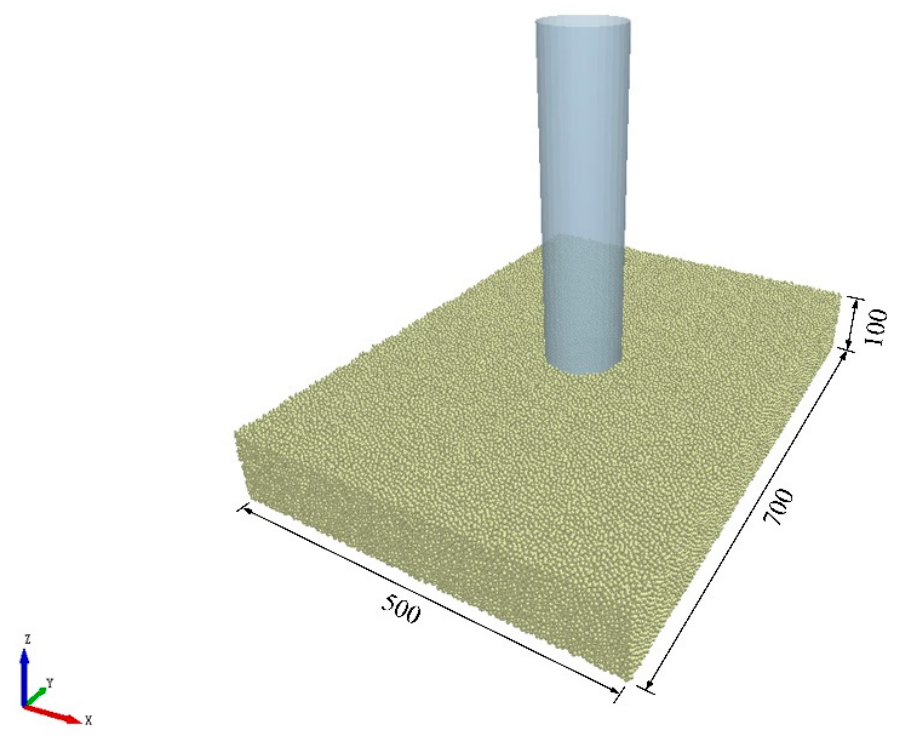
Figure 3. Seabed model (unit: